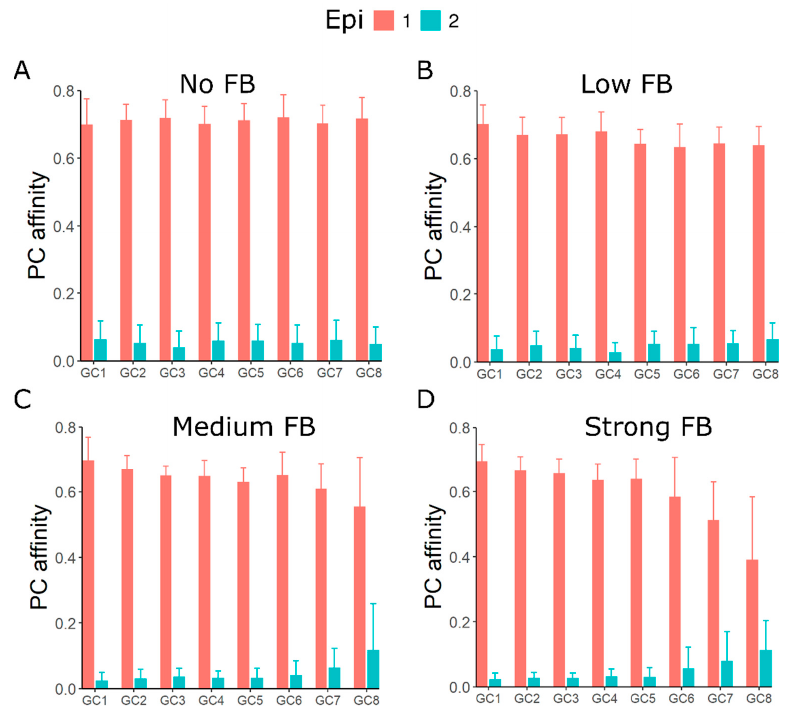
Figure 4. Affinity maturation to a rare and an immunodominant epitope. Affinity of plasma cells from asynchronously simulated GCs to two different epitopes, immunodominant (90%, Epi 1) and rare (10%, Epi 2), with different strengths of GC–GC interactions ( A – D ). Plasma cell affinity was calculated at the end of the GC simulation (40 days post immunization). Shape space positions of the two epitopes were 3333 (Epi 1) and 5555 (Epi 2) and founder cells were chosen randomly anywhere in the shape space. GCs 1–8 were sorted in the sequence of initiation. Colors represent the epitope to which affinity was